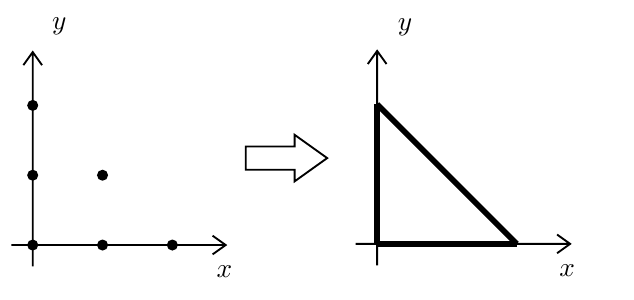
Figure 2 . supp( P ) (left) and N ( P ) (right) for P ( x; y ) = x 2 (cid:0) 2 xy + y 2 (cid:0) 2 x (cid:0) y +